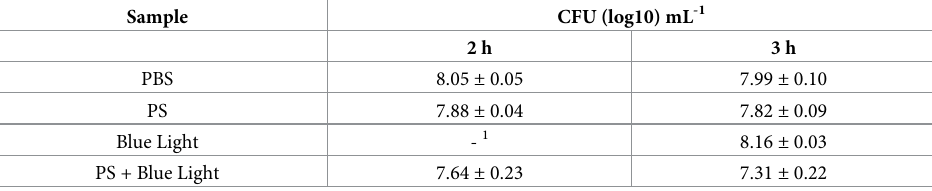
Table 1. Effect of blue light on E . coli using pheomelanin